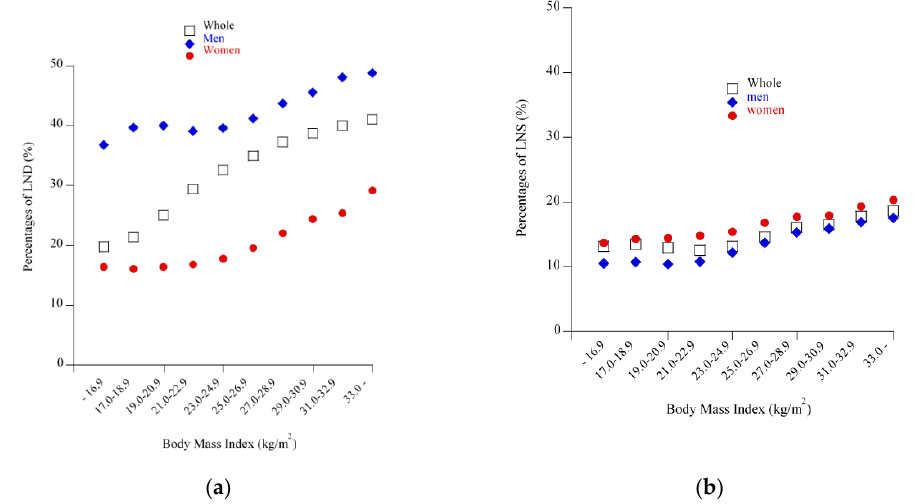
Figure 3. Percentages of late-night dinner (LND) and late-night snack (LNS) according to BMI categories and sex. ( a ) LND: All subjects, men, and women. ( b ) LNS: All subjects, men, and women. Each symbol indicates the percentage for that group.